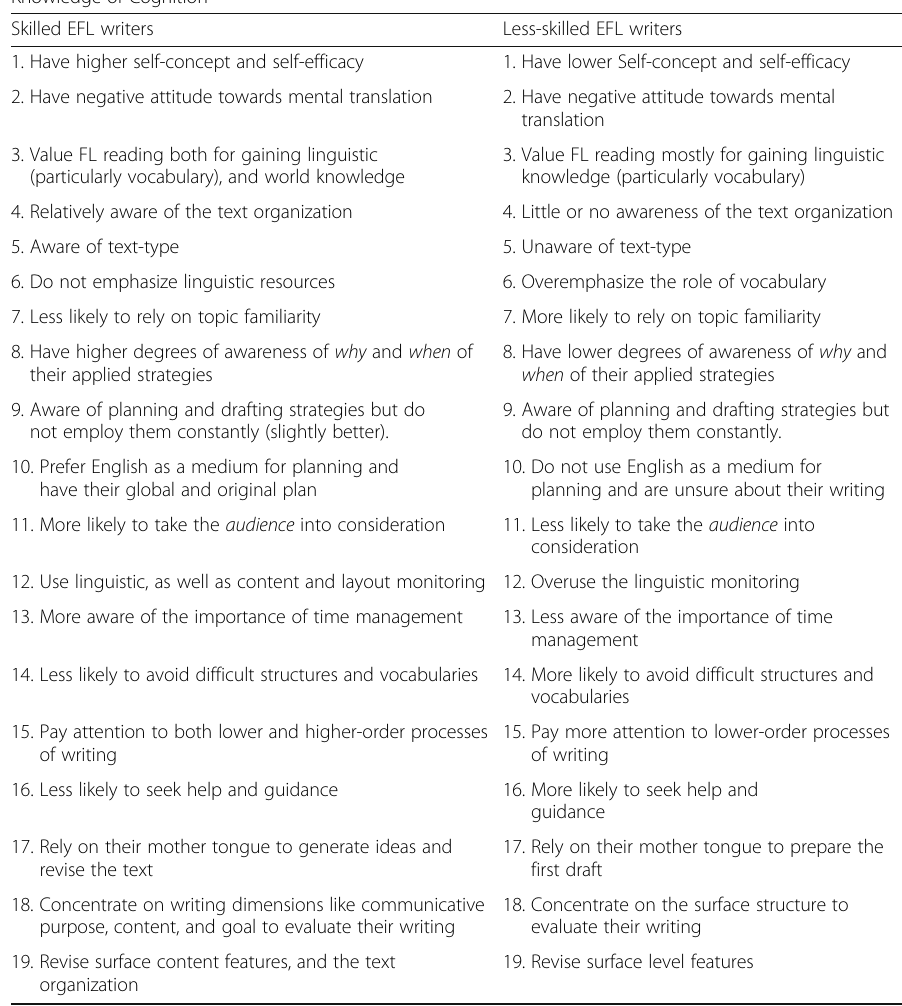
Table 1 Skilled vs. less-skilled EFL writing in terms of metacognitive awareness Knowledge of